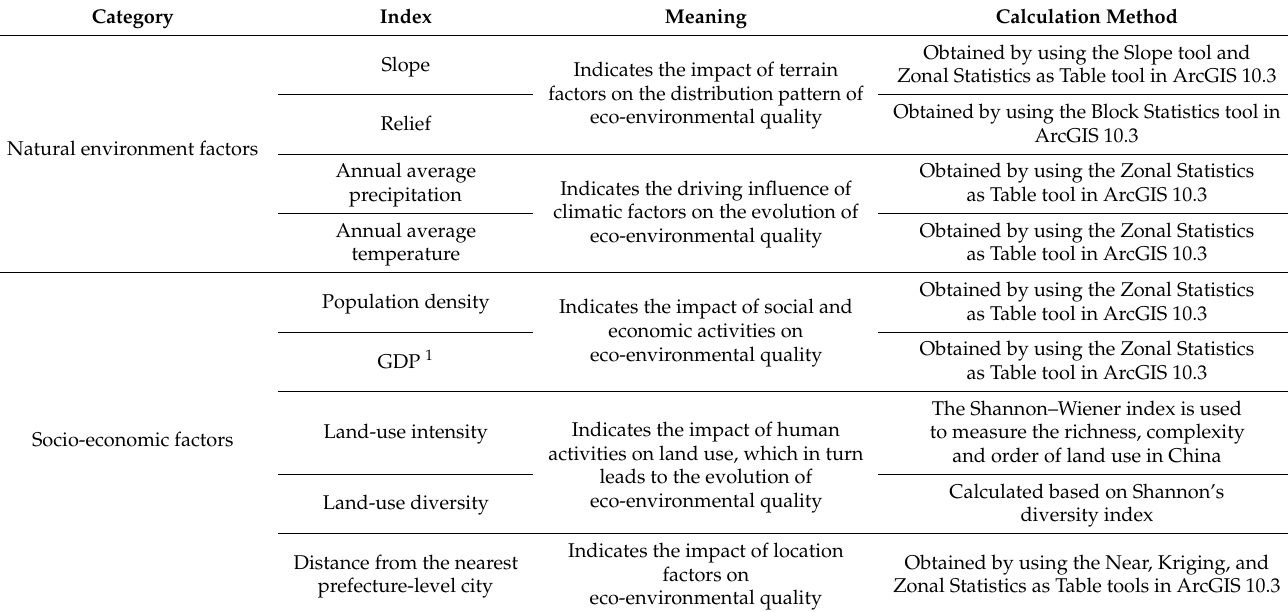
Table 3. The index system for the multi-scale geographically weighted regression (MGWR)